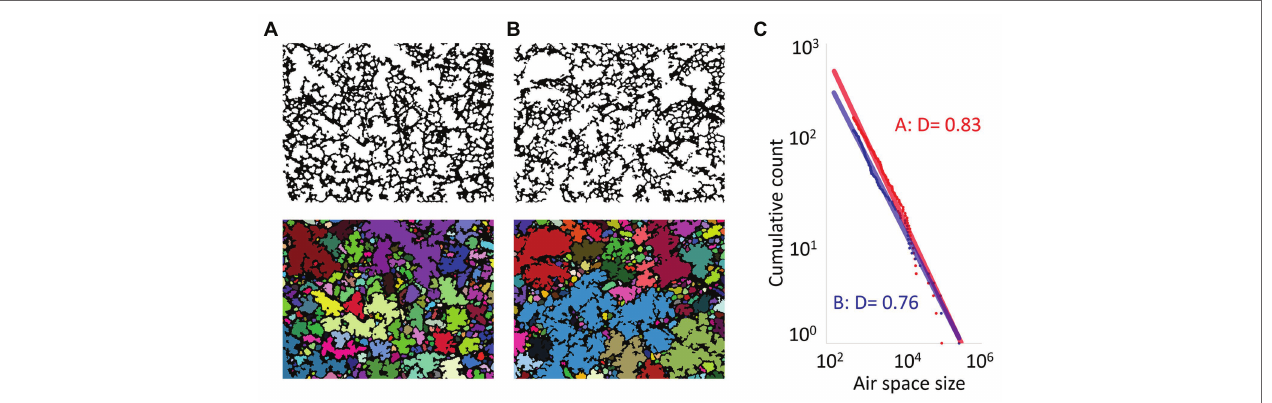
FIGURE 2 | The power-law exponent D of the size distribution of airspaces to evaluate emphysema on lung tissue. Histological sections on digital images were binarized and color segmented for each airspace in control (A) and an emphysematous mouse (B) . (C) Size of each airspace was measured. Then, the cumulative count of airspaces larger than a given size was plotted on a double logarithmic scale, and the power-law exponent D was calculated as the negative slope of the regression lines (D = 0.83 and 0.76 for control and emphysematous mice, respectively). Of note, the power-law exponent D for the size distribution of airspaces is not the FD of airspace